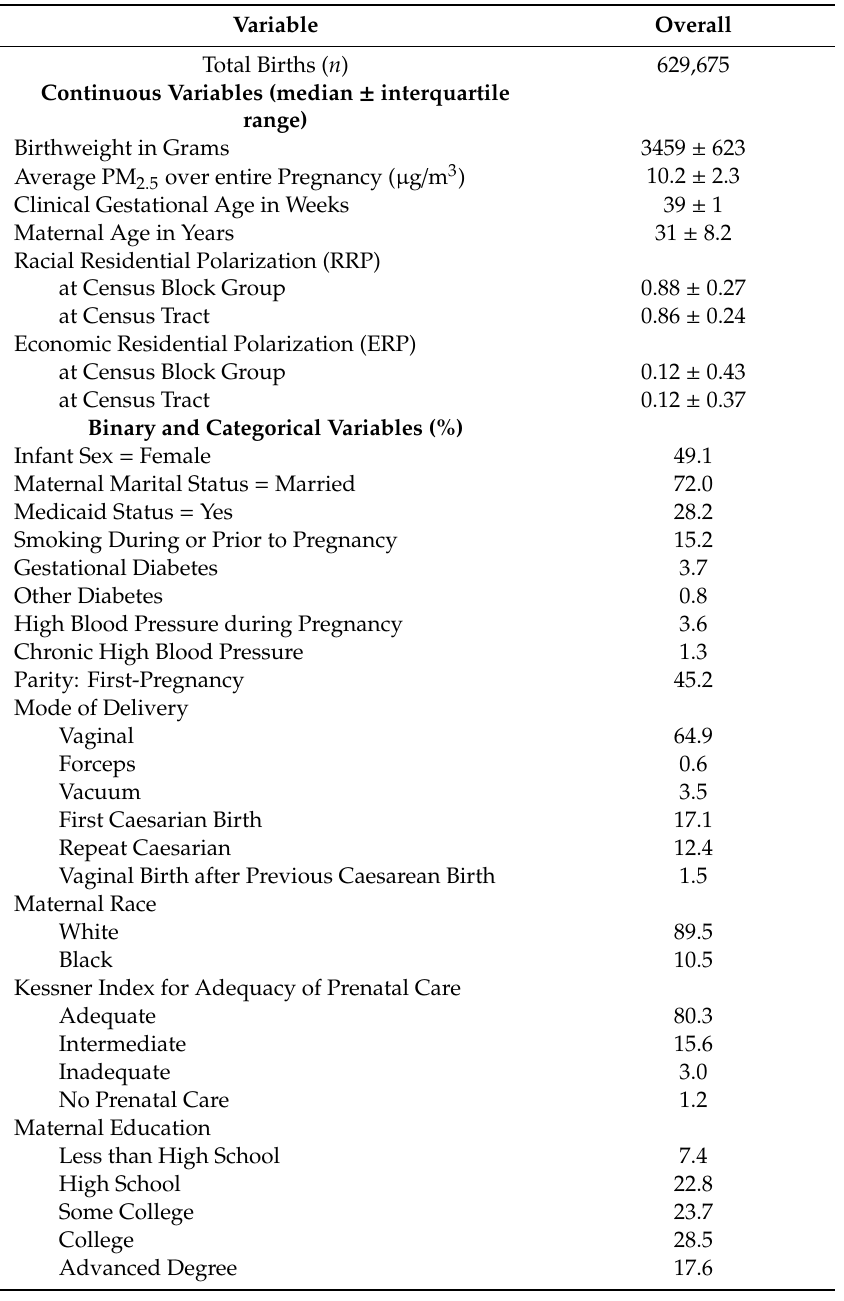
Table 1. Characteristics of Full-Term Live Singleton Births born to White and Black Mothers in Massachusetts from 2001 to